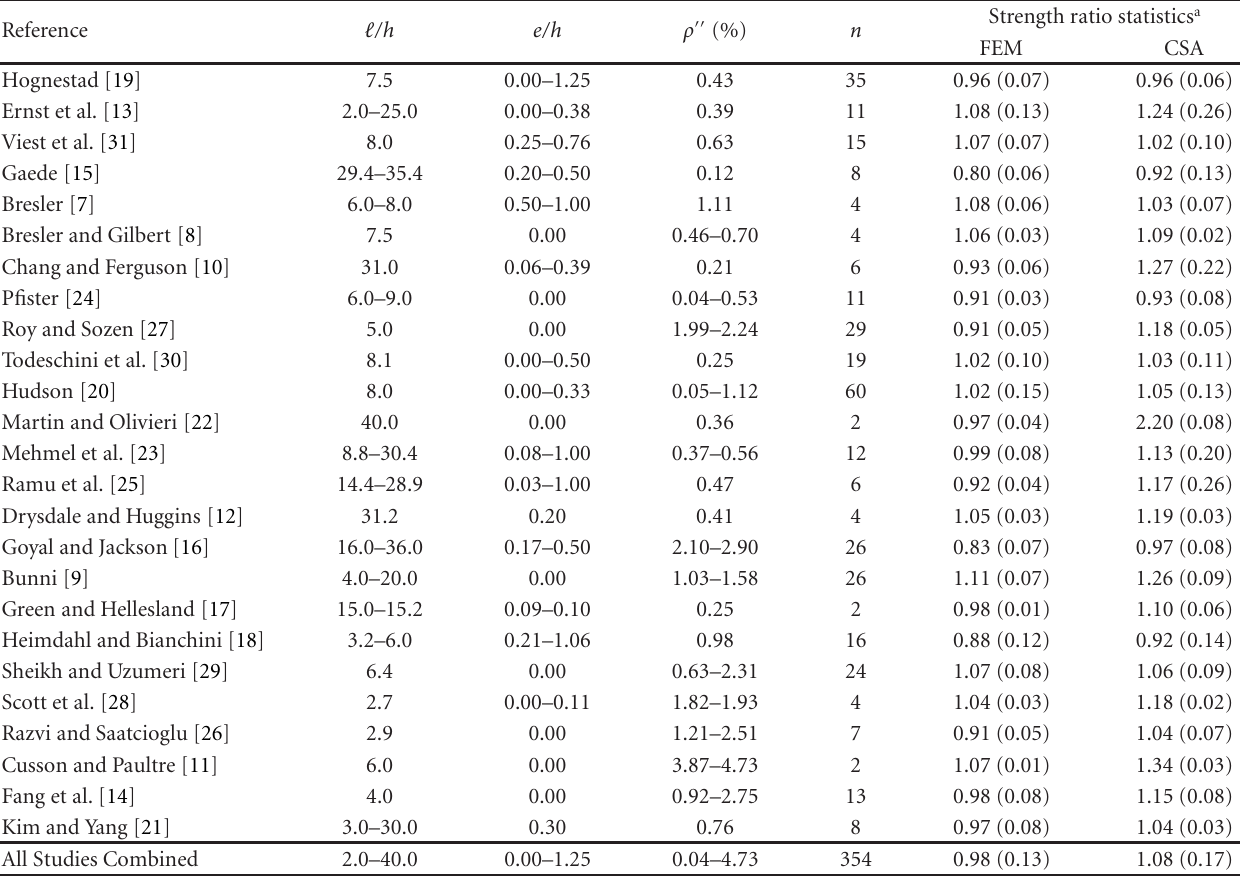
Table 3: Strength ratio statistics for reinforced concrete